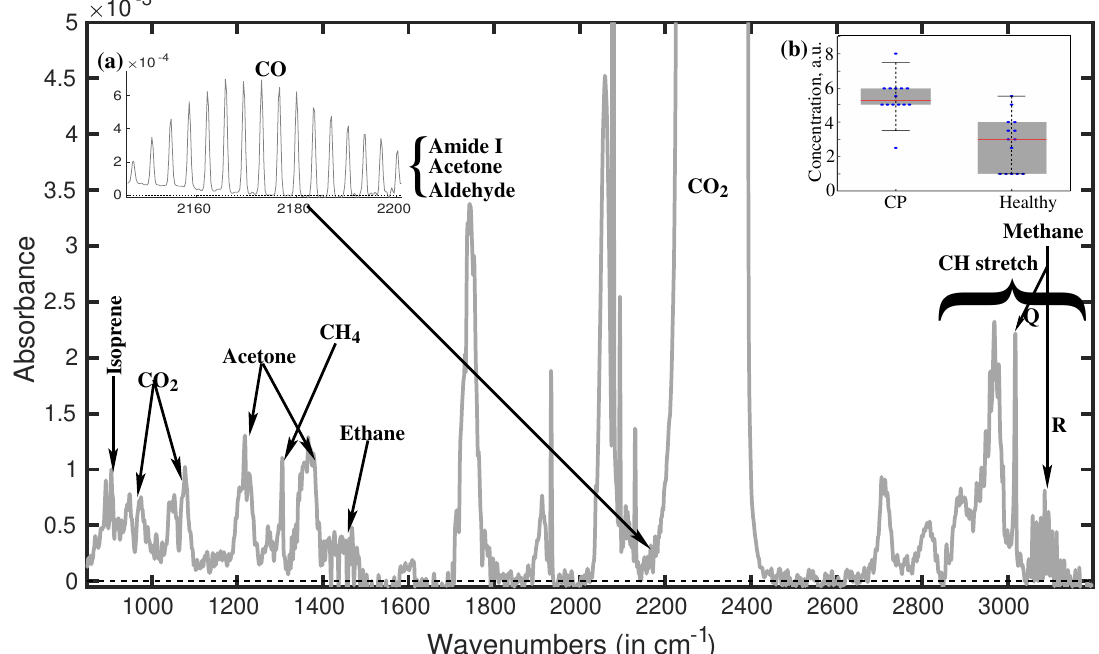
Figure 1. Water suppressed breath spectra of a healthy volunteer. In inset (b) spectral strength of peak at 1189cm − 1 Few fingerprints are labeled. Many fingerprints are still buried under these strong